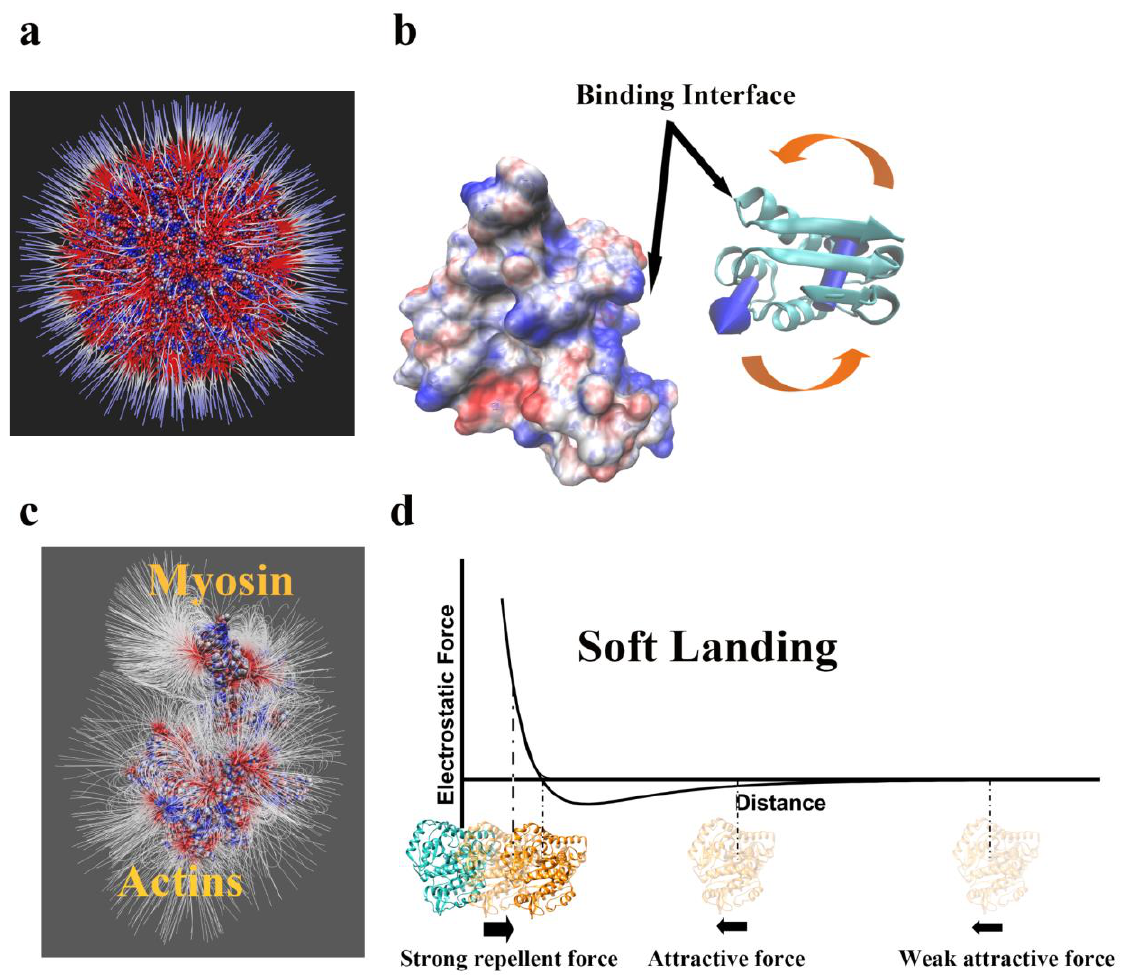
Figure 2. ( a ) Electrostatic features surrounding a viral capsid (PDB ID: 5J36 [59]). The electrostatic potential and electric field lines on the surface of the viral capsid illustrate the electrostatic interactions among the capsomer proteins. ( b ) The torque in barnase–barstar binding, where the barstar was separated by 20 Å and rotated by 90° to show the torque on the barstar. ( c ) The electric field lines on the myosin – actin complex, where the myosin and actin were separated by 15 Å to show the electric field lines. ( d ) The relationship between the electrostatic force and distance in protein–protein interactions. The blue one is alpha-tubulin while the orange one is beta-tubulin.